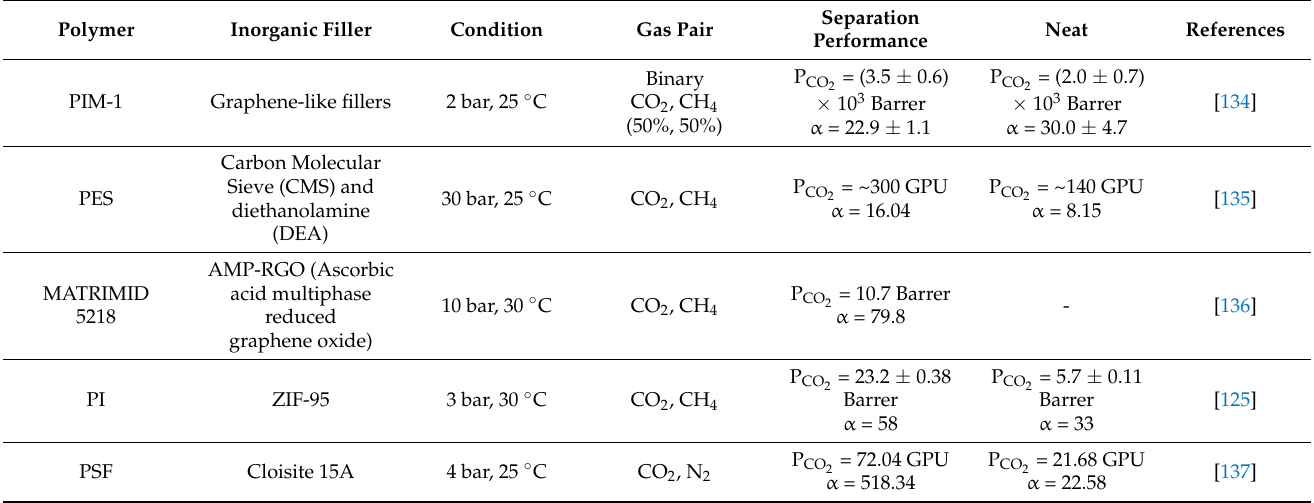
Table 6. Summary of MMM performance for different gas